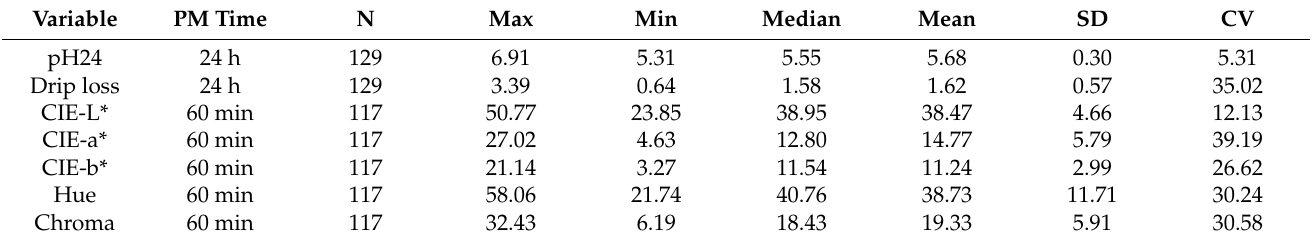
Table 1. Descriptive statistics of meat quality traits of Longissimus thoracis et lumborum meat of total sample